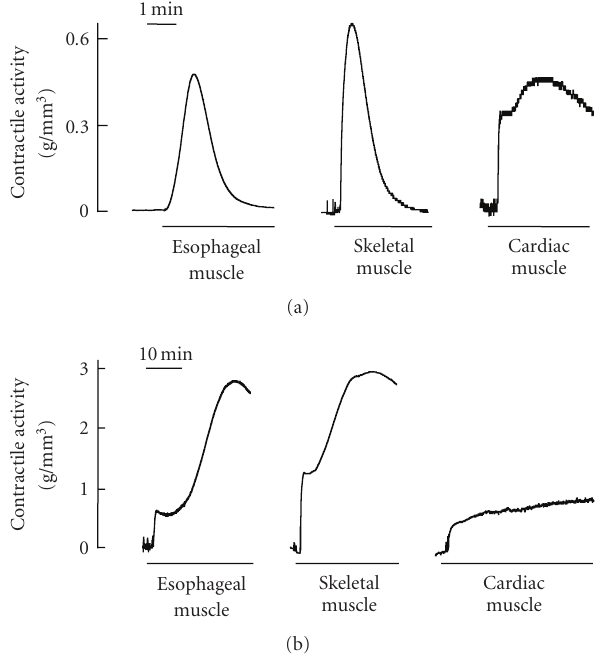
Figure 4: Contractile responses induced by high potassium or ca ff eine in esophageal, skeletal, and cardiac muscles. Muscle preparations were stimulated with high potassium (a) or ca ff eine (b). Representative traces of the contractile responses in esophageal, skeletal and cardiac preparations are shown. Similar results were reproducibly obtained in five independent experiments. Underbars indicate the application of high potassium (118.4 mM) and ca ff eine